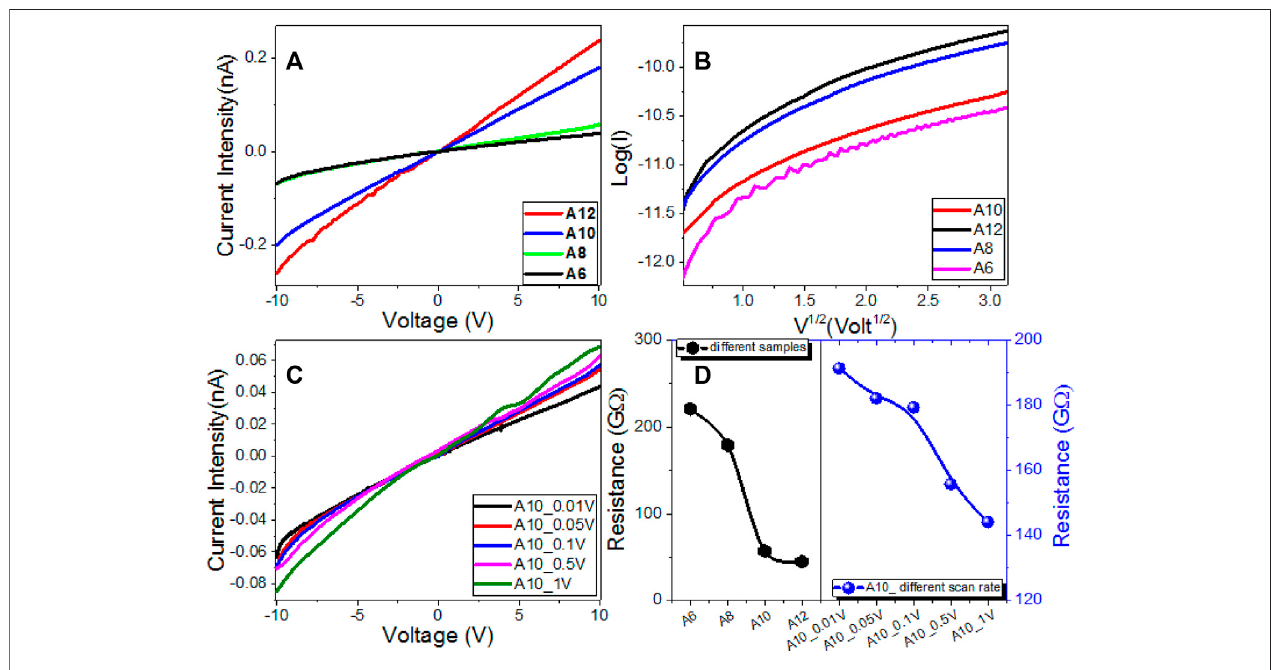
FIGURE 7 | Electrical characteristics of An series: (A) Current-Voltage characteristics of An series, (B) Log(I) vs. V 0.5 For S10 sample at different step scans, (C) Current-Voltage characteristics of A10 sample at different step scans, and (D) electric resistance for the An samples and A10 at different step scans.